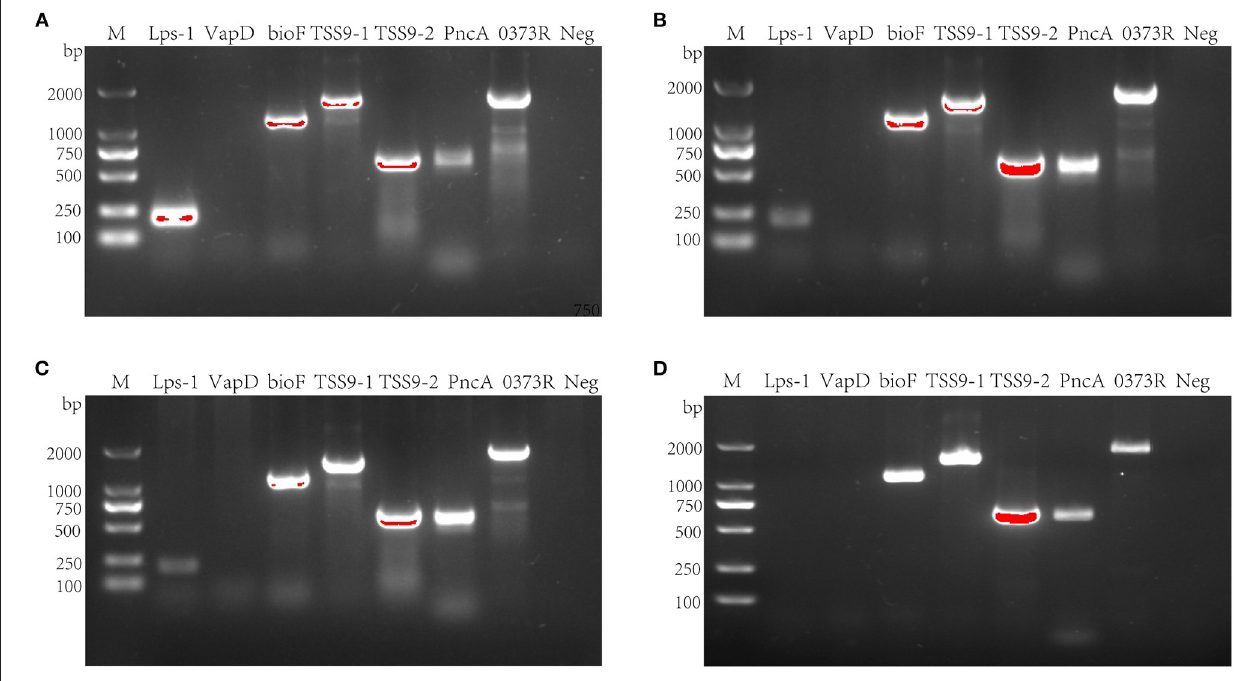
FIGURE 5 | Virulence gene detection of R. anatipestifer . (A) Virulence gene detection of serotype 1 R. anatipestifer. (B) Virulence gene detection of serotype 3 R. anatipestifer. (C) Virulence gene detection of serotype 5 R. anatipestifer. (D) Virulence gene detection of serotype 15 R. anatipestifer. M means DNA marker; 0373R means 0373Reight gene; Neg means negative